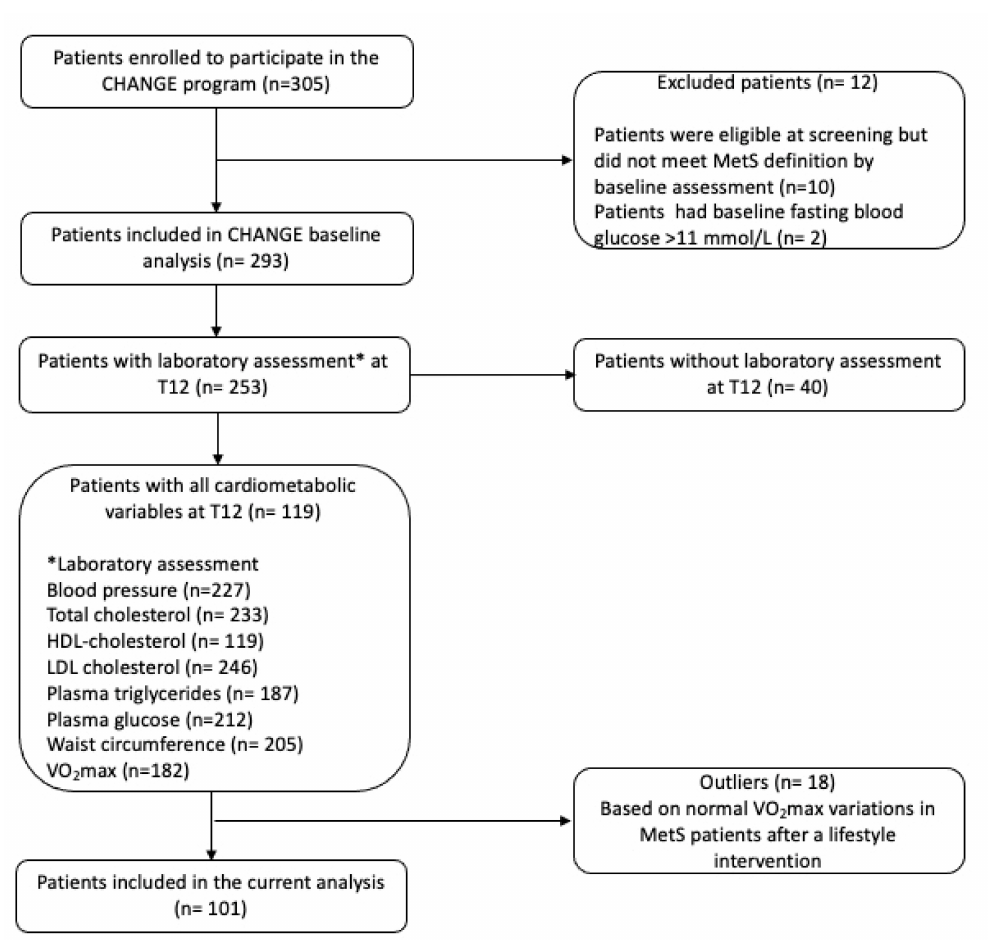
Figure 1. Flowchart of the patient’s eligibility in the present study. Abbreviations: CHANGE, Canadian Health Advanced by Nutrition and Graded Exercise; T12, end of intervention at 12